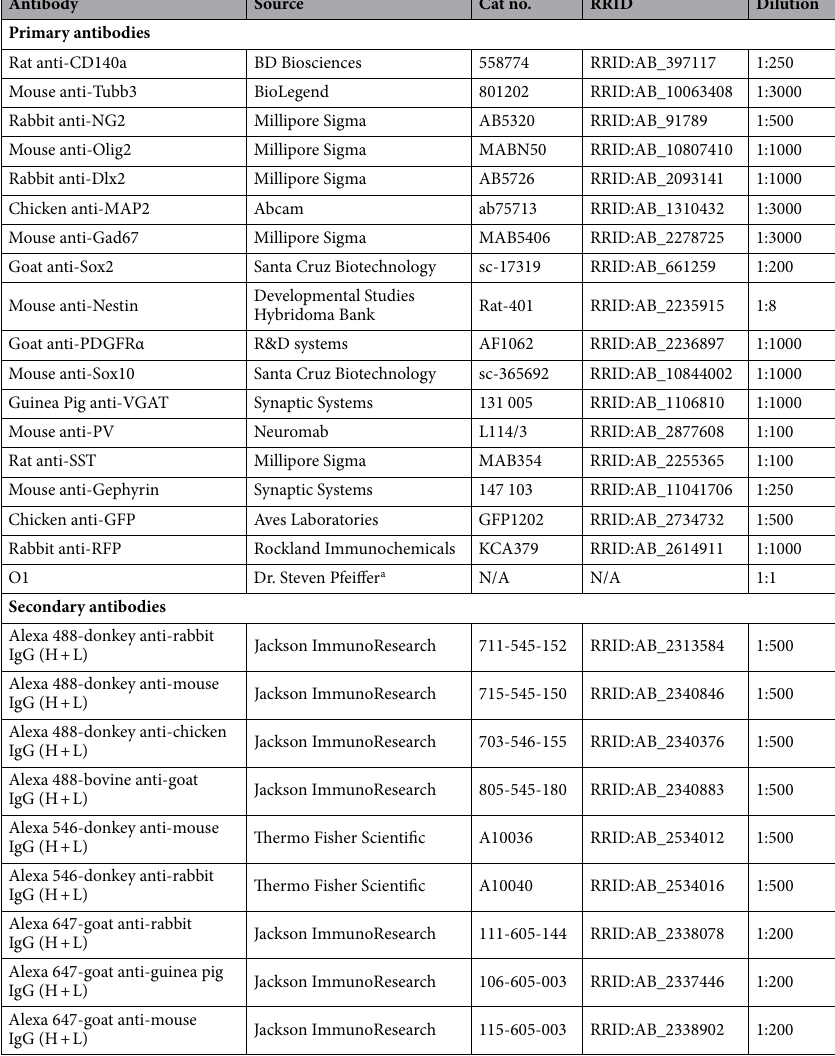
Table 1. Antibodies used. a University of Connecticut Health Center, Farmington,